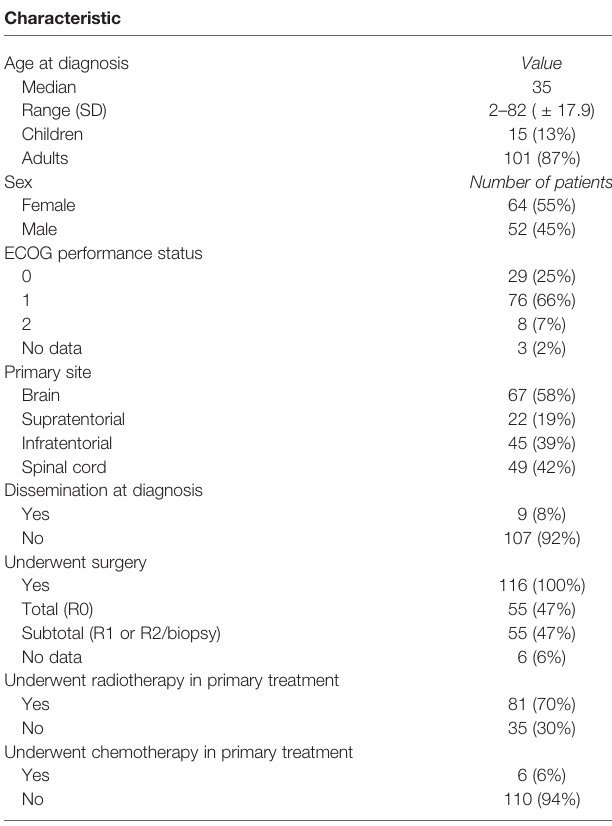
ECOG, Eastern Cooperative Oncology Group; R0, radical resection (macro- and microscopically); R1, macroscopically radical resection (but not microscopically); R2, macroscopically nonradical resection; SD, standard